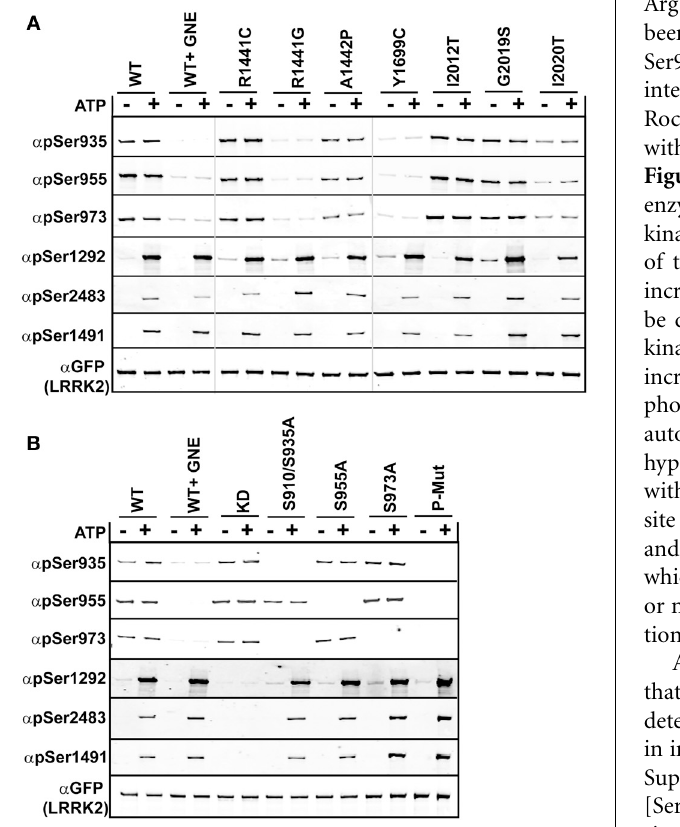
FIGURE 2 | Comparison of autophosphorylation and cellular phosphorylation sites in PD-associated mutants. Stable-inducible HEK 293 T-REx cell lines harboring the indicated forms of LRRK2 were incubated for 48h with 1 μ g/ml doxycycline to induce expression. The GFP-LRRK2 WT line was treated with 1 μ M GNE1023 for 90min, before immunoprecipitation-kinase assay using GFP beads, in the presence ( + ) or absence ( − ) of ATP. LiCor immunoblot analysis of (A) WT and PD associated mutants of LRRK2 and (B) WT and cellular phosphorylation mutants. Reaction products were probed with rabbit monoclonal anti-phospho-Ser935 ( α pS935), anti-phospho-Ser955 ( α pS955), anti-phospho-Ser973 ( α p973), anti-phospho-Ser1292 ( α pS1292), anti-phospho-Thr2483 ( α pThr2483), anti-phospho-Thr1491 ( α pThr1491). Blots were probed with anti-GFP ( α GFP) for total protein control. Phosphorylation levels are quantitated in Supplemental Figure